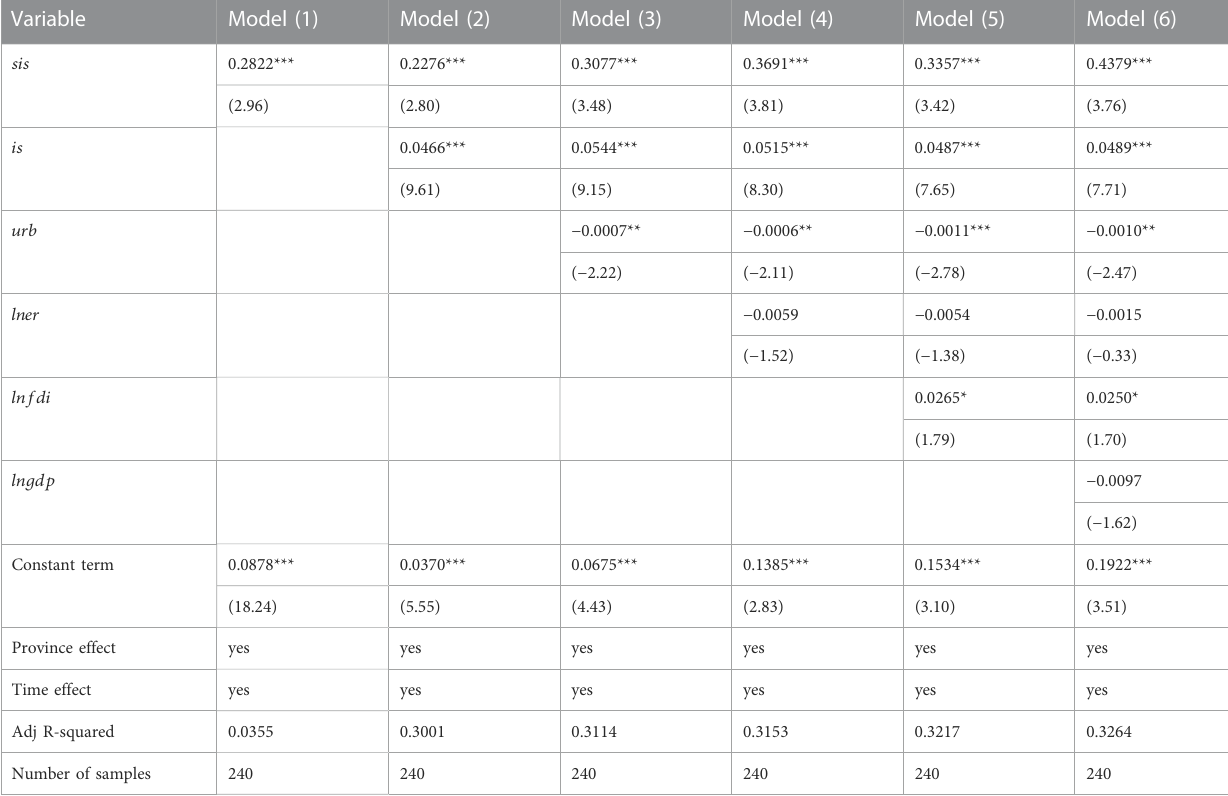
TABLE 4 Benchmark regression results of sports industry agglomeration affecting the high-quality development of green energy.